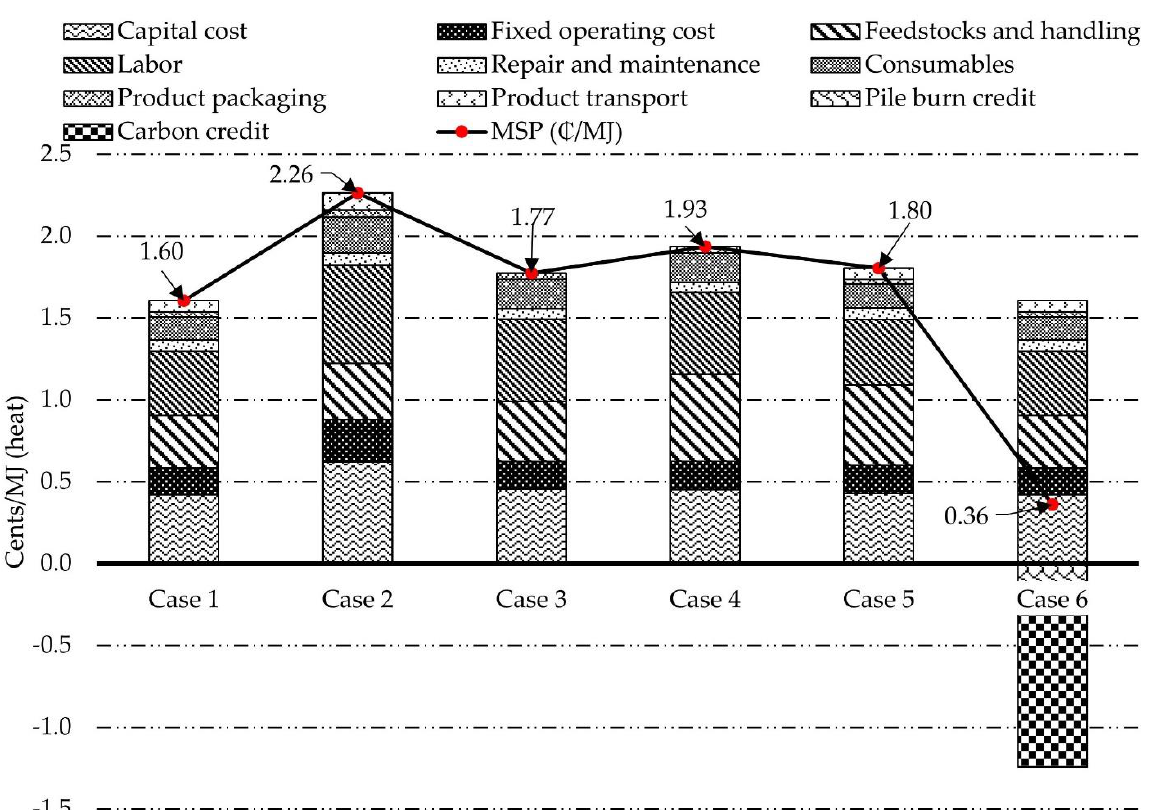
Figure 7. Comparison of minimum selling price (MSP) per 1 MJ of heat generated using torrefied wood briquettes and contributions of various costs inputs to MSP in six cases. Case 1: near-woods operation with wood biomass gasifier power; Case 2: near-woods operation with diesel power; Case 3: in-town operation (2 h travel distance) with grid power; Case 4: in-town operation (4 h travel distance) with grid power; Case 5: 50% moisture content b feedstock, near-woods operation with wood gasifier power; Case 6: near-woods operation with wood gasifier power with pile and burn credit.